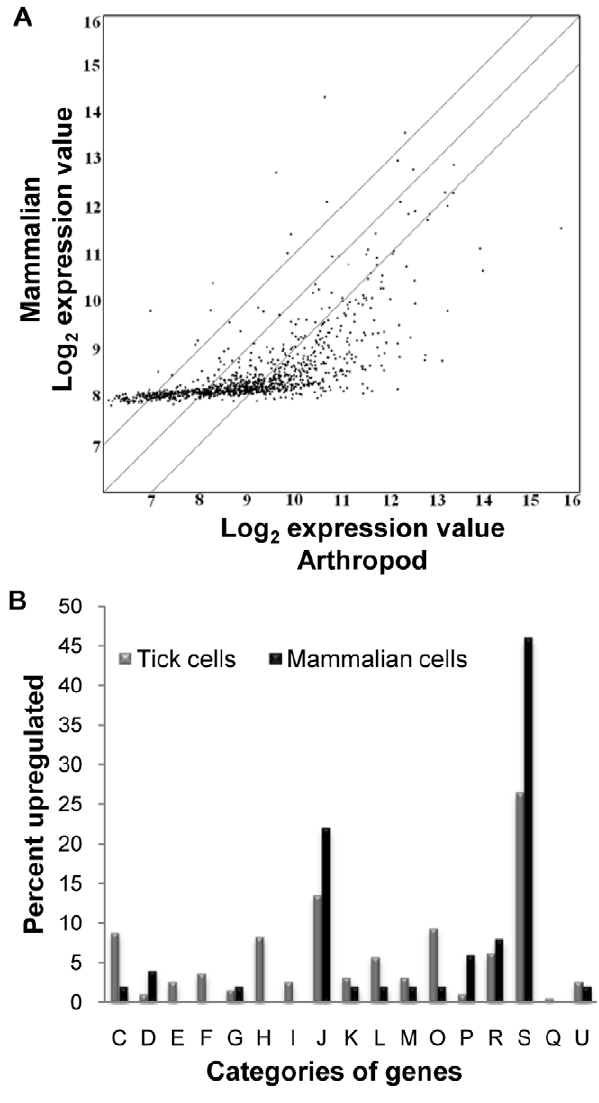
Figure 2. Genes upregulated by E.chaffeensis in human and tick cells. (A) Scatter plot of expression in mammalian (THP-1) vs. arthropod (AAE2 and ISE6) cells, center line represents equivalence and outer lines indicate two fold difference. Images generated using ArrayStar H . (B) Distribution of significantly upregulated E. chaffeensis genes in mammalian cells (black bars) and tick cells (grey bars) classified to Clusters of Orthologous Groups (COGs). C: Energy production and conversion, D: Cell cycle control and mitosis, E: Amino acid metabolism and transport, F: Nucleotide metabolism and transport, G: Carbohydrate metabolism and transport, H: Coenzyme metabolism, I: Lipid metabo- lism, J: Translation, K: Transcription, L: Replication and repair, M: Cell wall/membrane/envelope biogenesis, O: Post-translational modifica- tion, protein turnover, chaperone functions, P: Inorganic ion transport and metabolism, R: General functional prediction only, S: